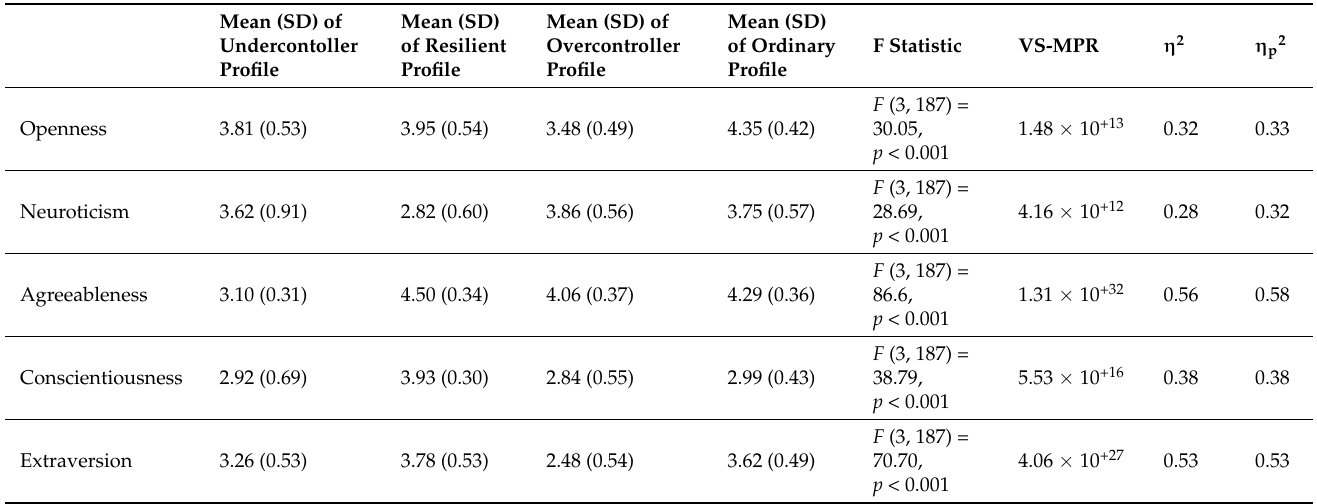
Table A1. Means, Standard Deviations, ANCOVA F statistic, Vovk-Sellke Maximum p-Ratio, and eta squared of FFM-Only